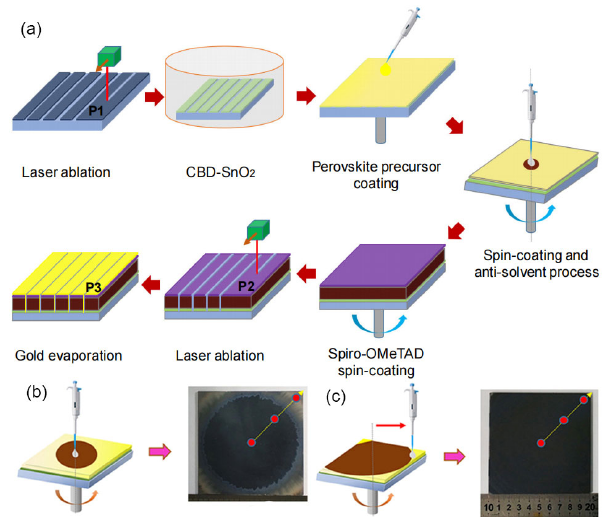
Figure 2 (a) Illustration of the procedure for PPMs fabrication. Schematic diagrams and photographs of the 10 cm × 10 cm perovskite film by (b) antisolvent quenching process on the center and (c) dynamic antisolvent quenching process from the center to the edge. Reproduced with permission from Ref. [30], © WILEY-VCH Verlag GmbH & Co. KGaA,